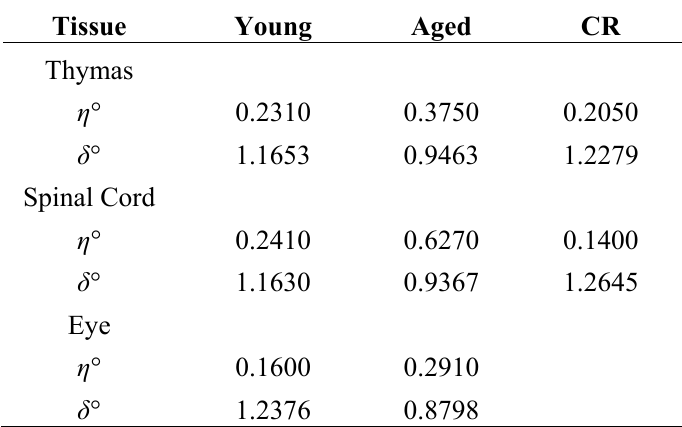
Table 1. The network robustness ( η °) and network response ability ( δ °) of a gene regulatory network with 16 aging-related genes (Figure 4) across different tissues at young, aged, and calorie-restrictive (CR)